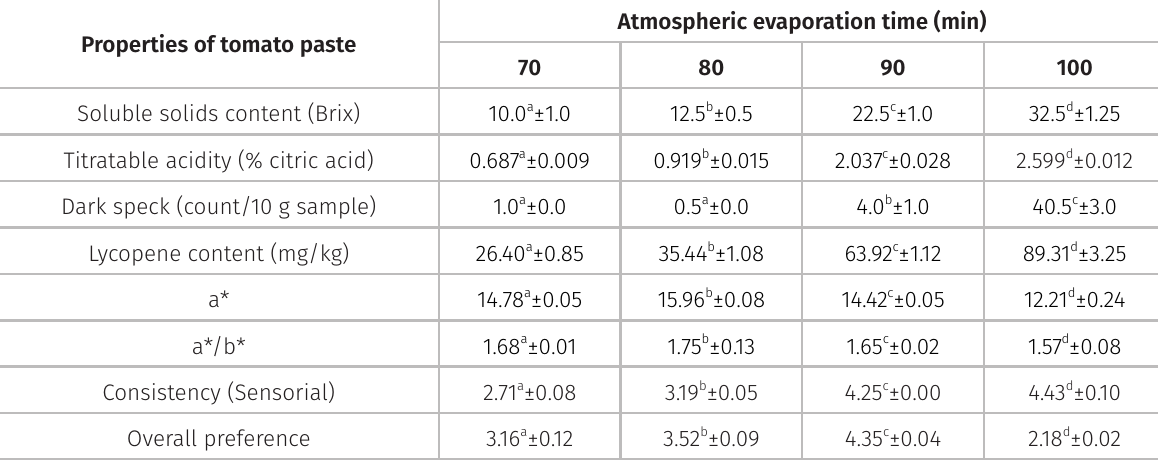
Table III. Physical, chemical and sensorial properties of atmospheric evaporated tomato paste.